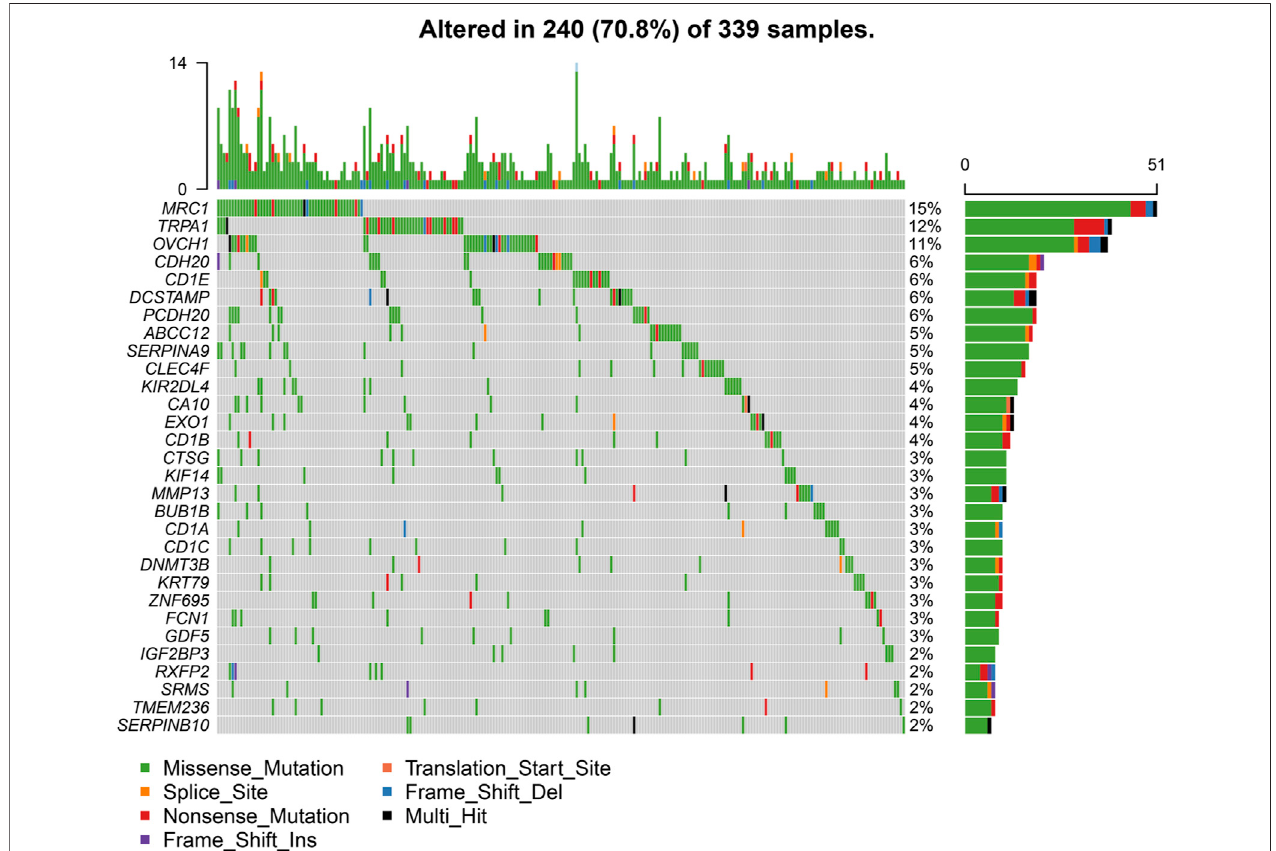
FIGURE 9 | Waterfall plot of mutated genes in the CCL17-related module genes in TCGA-LUAD. The different color annotations in the waterfall plot represent different mutation types, and the plot shows the mutation frequencies of the top 30 genes in the sample.